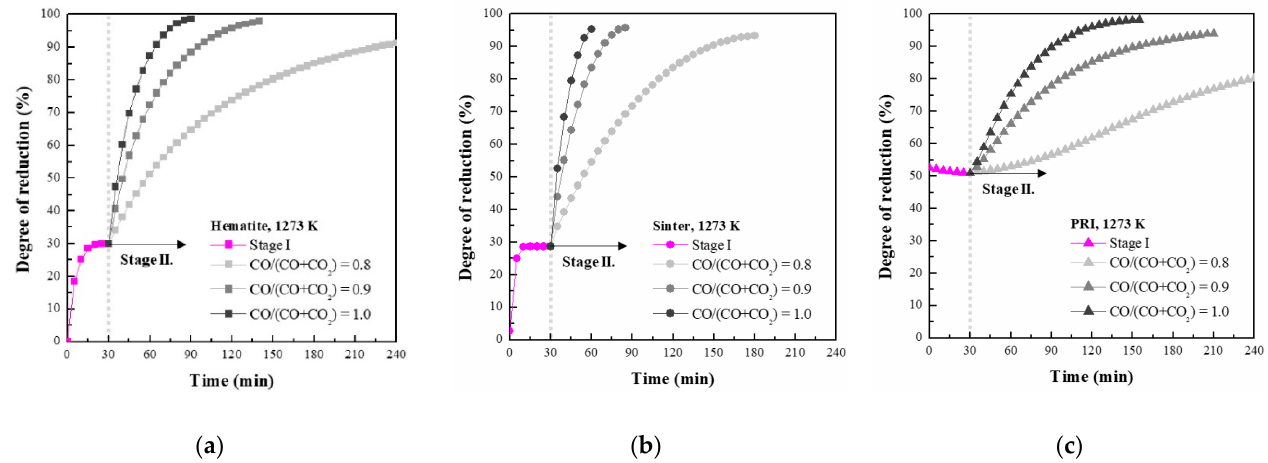
Figure 4. Reaction behaviour of ( a ) hematite, ( b ) sinter, and ( c ) PRI under the experimental conditions of Stage II.